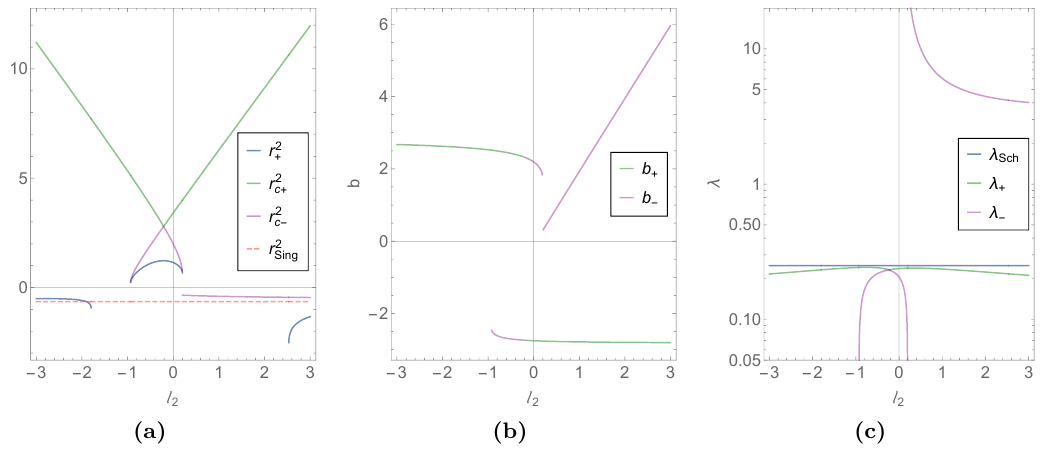
Figure 4. (a) In red the maximum values of r 2 , in blue the values of r 2 , In green and purple the + sing values of r 2 and r 2 respectively. (b) In green and purple the values of b c, + and b c, − respectively. c, + c, − (c) In green and purple the values of λ + and λ − respectively. In all plots we set M = 1 , Q = 0 . 5 and ‘ 1 = 0 . 8